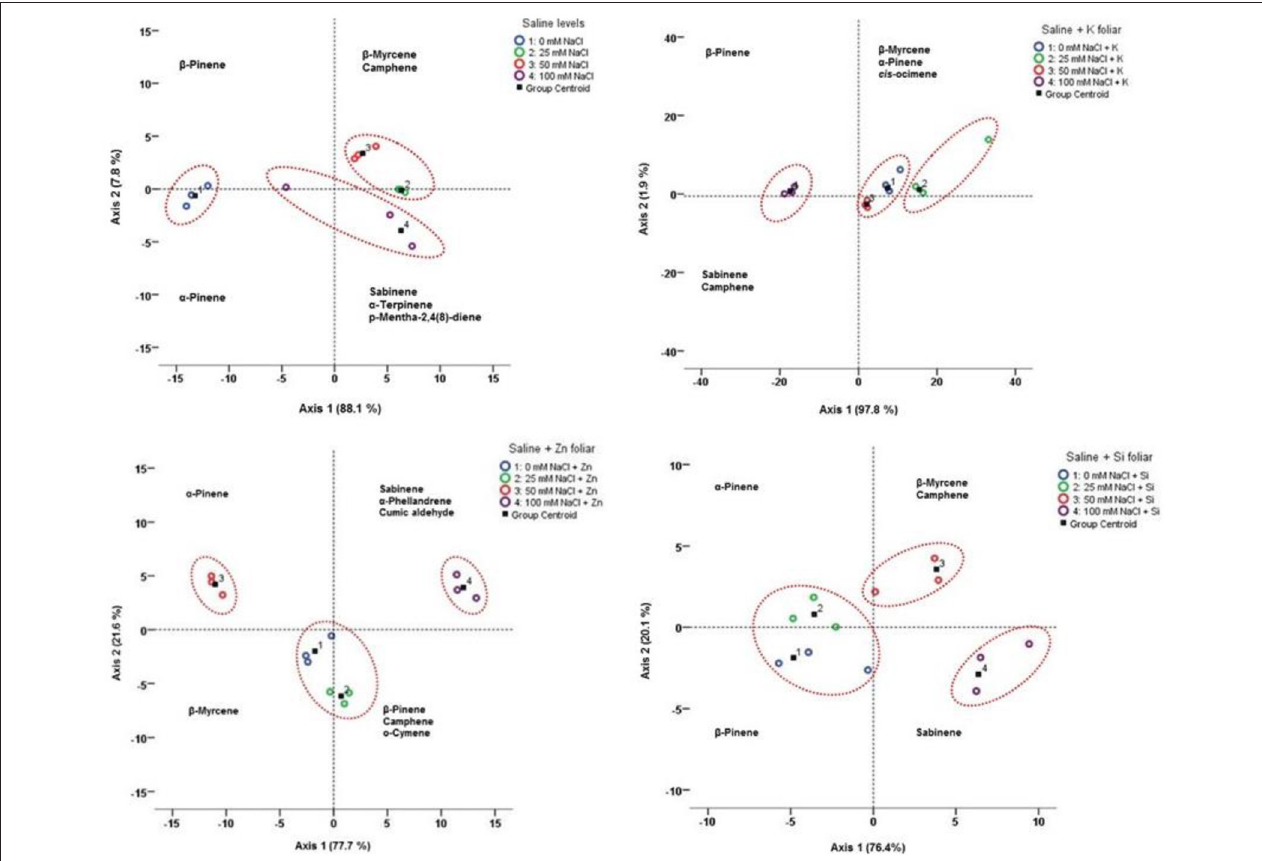
FIGURE 8 | Linear discriminant analysis (LDA) for the lavender essential oil compounds under different saline levels with K, Zn, Si foliar applications. Projection of the average contents of the essential oil compounds onto the first two principal axes ( + and – indicate positive and negative correlations with axes, respectively). Coding numbers referred to mM NaCl + foliar